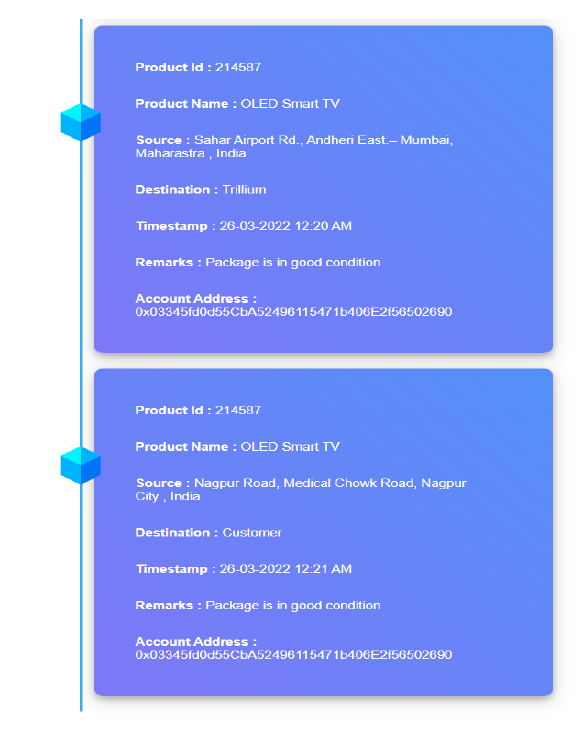
Figure 17: Supply chain history -